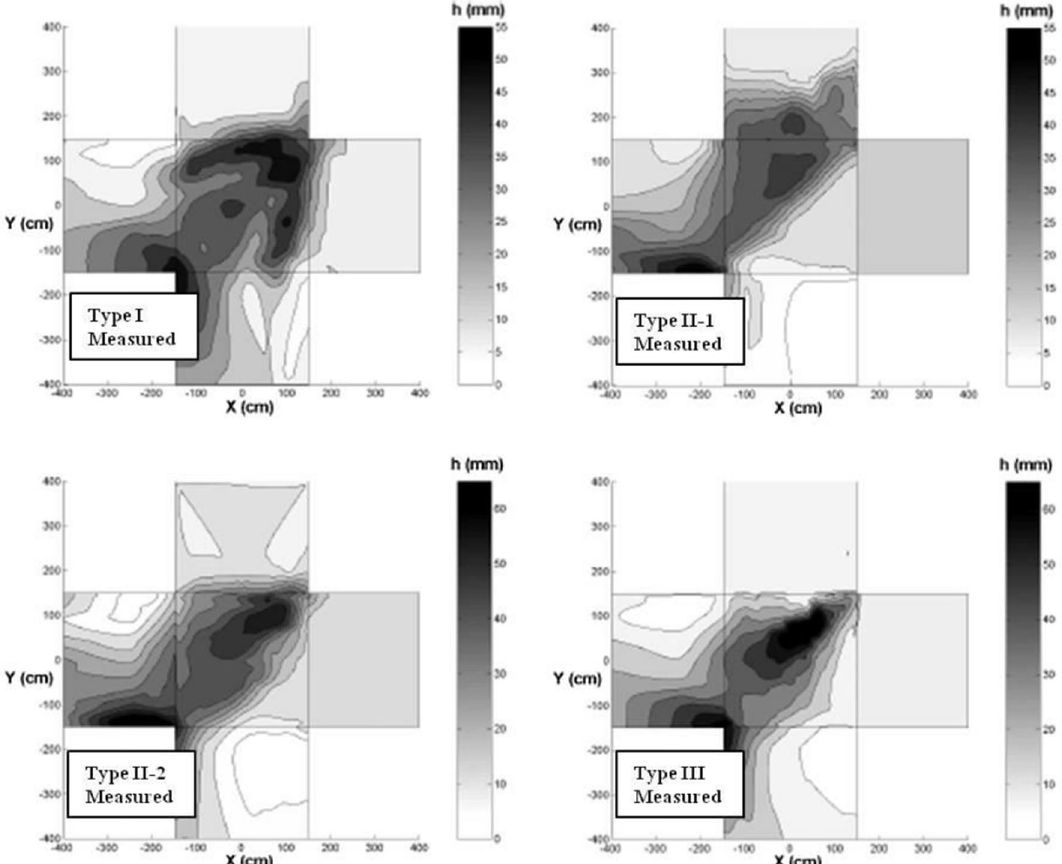
Fig. 2 Water-depth distributions within and around a confluence for four flow types (Mignot et al.